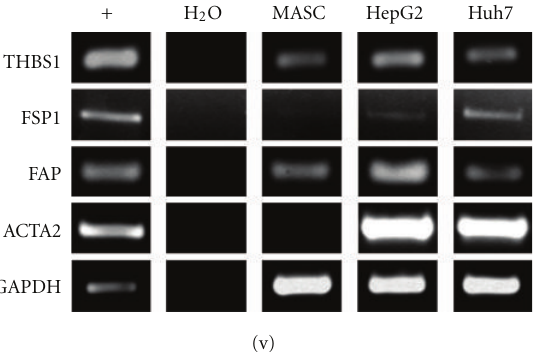
Figure 5: L-MASCs cultured in the presence of tumor-conditioned medium (CM) acquire an activated phenotype. (a–u) Protein expression of TAF-markers. L-MASCs cultured in non-CM (a, d, g, j, m, p, s), in HepG2-CM (b, e, h, k, n, q, t), and in Huh7-CM (c, f, i, l, o, r, u) were assessed for the expression of vimentin (green fluorescence, (a–c)), nestin (green fluorescence, (d–f)), cytokeratines (green fluorescence, (g– i)), desmin (green fluorescence, (j–l)), smooth muscle actin (green fluorescence, (m–o)), tenascin-C (p–r)), and VEGF (green fluorescence, (s–u)). Nuclei are depicted by the blue fluorescence of DAPI staining. Scale bar = 30 μ m (a–o), 20 μ m (p–u). (v) mRNA expression of TAF markers. Representative RT-PCR evaluating the expression of THBS1, FSP1, FAP, ACTA2, and GAPDH in L-MASCs cultured in non-CM, HepG2-CM, and Huh7-CM, respectively. HeLa was utilized as positive control